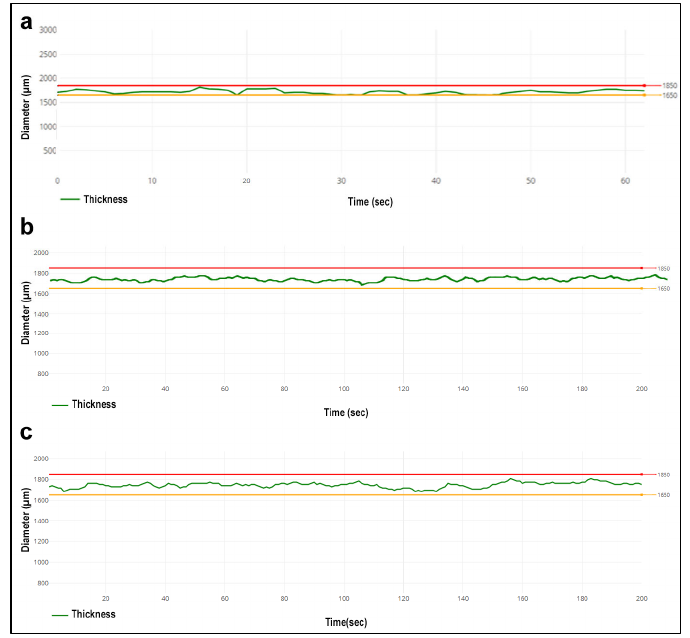
Figure 5. Time-dependent change of filament thickness during production ( a ) Drug-free PCL fila- ment, ( b ) PCL fi lament containing PCX:CD inclusion complex, ( c ) PCL fi lament containing CBP:CD inclusion complex.